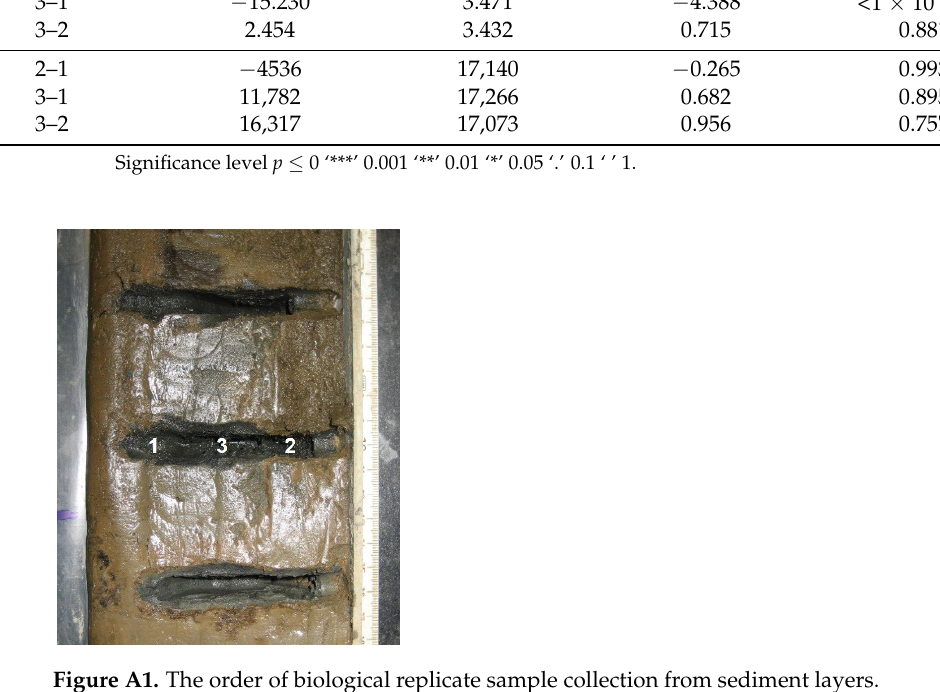
Table A3. Multcomp Tukey test showing a correlation between biological replicates taken from a sediment core in the shown order.